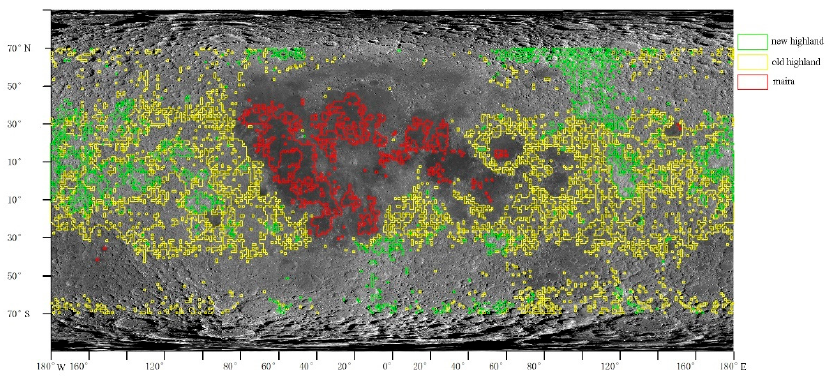
Figure 1. Three areas we divided: ‘maria’, ‘new highland’ and ‘old highland’ (The different of ‘new highland’ and ‘old highland’ is the maturity of the Lunar soil. The maturity of lunar soil in ‘new highland’ was low while that in ‘old highland’ was high) (base map is global mosaic of the moon by Lunar Reconnaissance Orbit (LRO), resolution is 200/pixel, http://wms.lroc.asu.edu/lroc/view_rdr/WAC_GLOBAL).